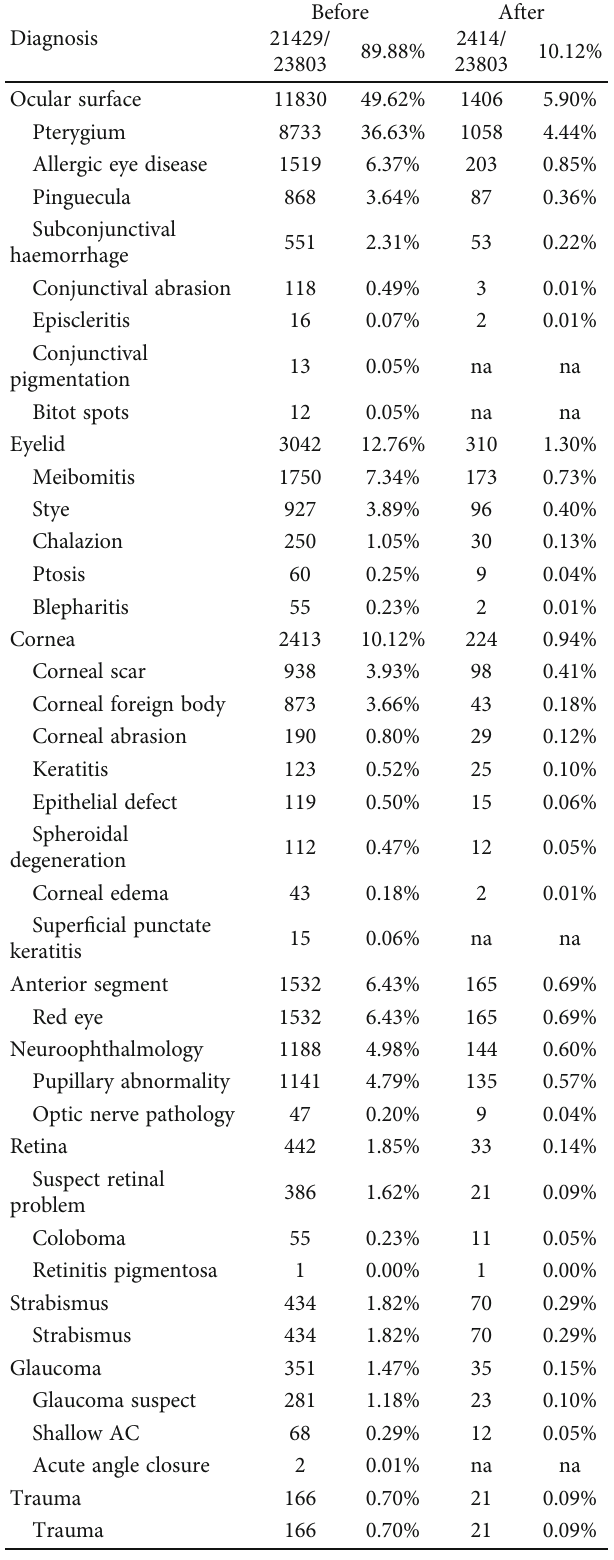
Table 2: Ocular diagnosis distribution in patients whose teleophthalmology consultation was missed and not sent (Category